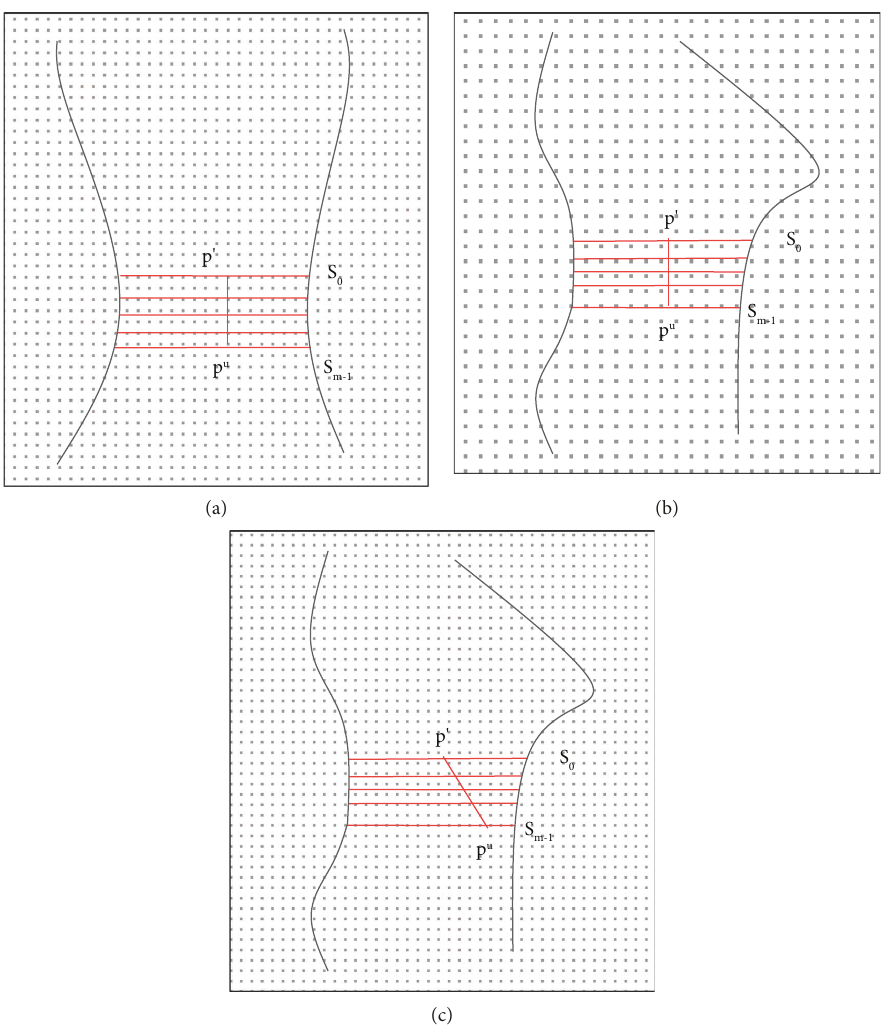
Figure 6: Projection of digital clothing human body. (a) Orthographic projection of the length of the front and back vertical curves. (b) Side projection of vertical curves on both sides. (c) Side projection of the length of the inclined